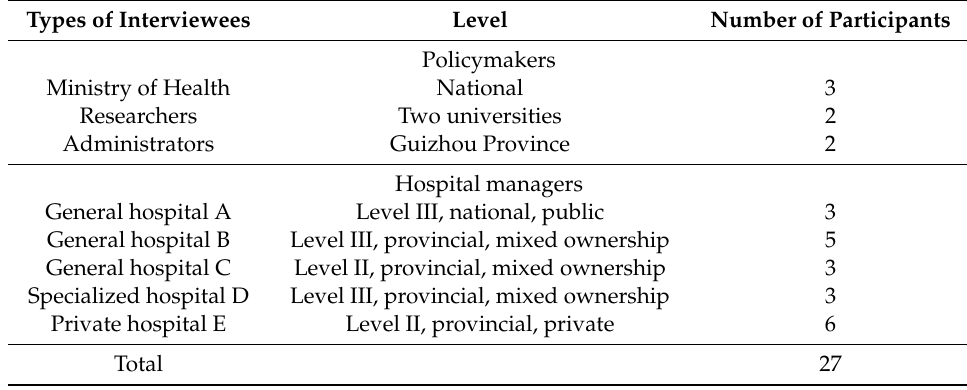
Table 1. Number of interviewees listed in order of administrative level and facility. Types of